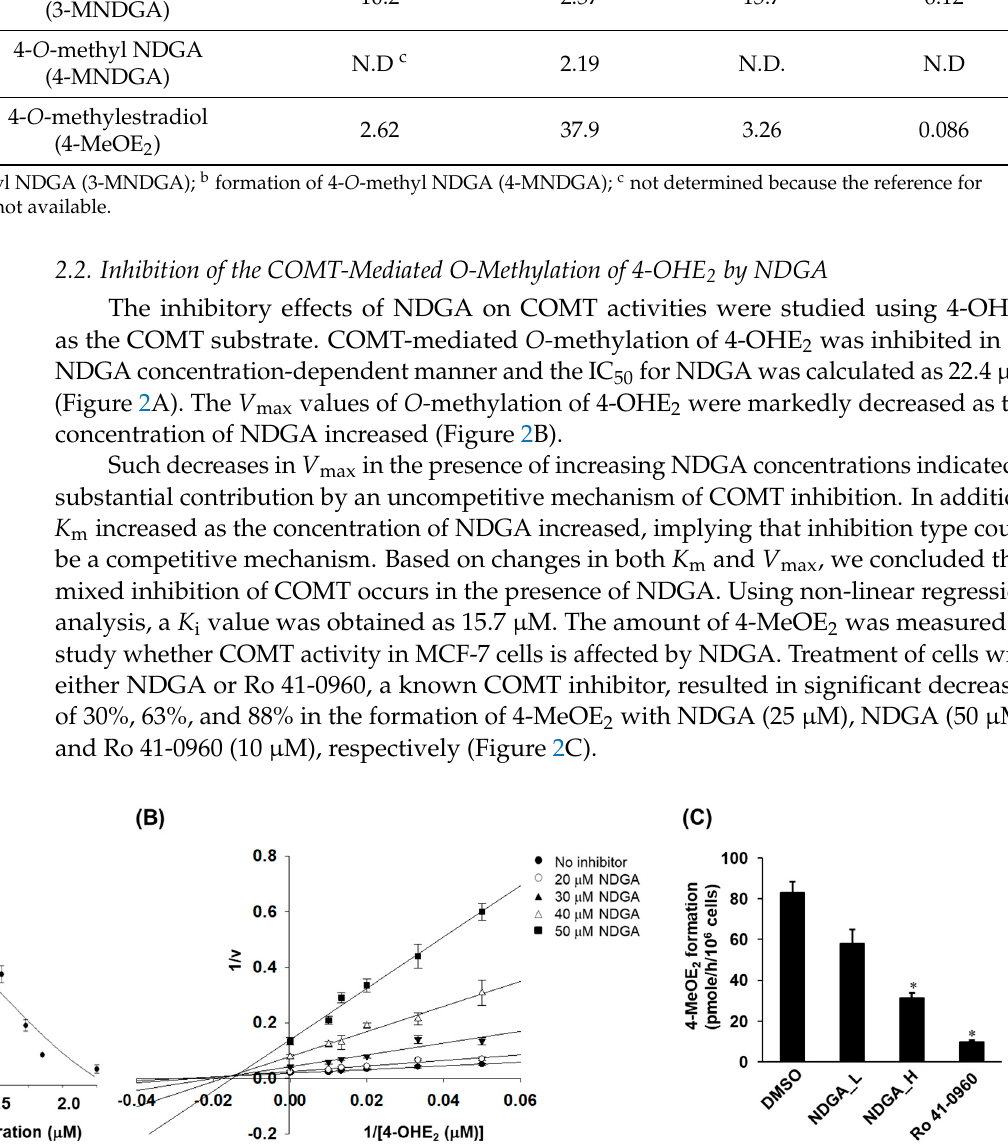
Table 1. Kinetic parameters in O -methylation of nordihydroguaiaretic acid (NDGA) and 4-hydroxyestradiol (4-OHE 2 ) by human recombinant soluble catechol O -methyl transferase (COMT).